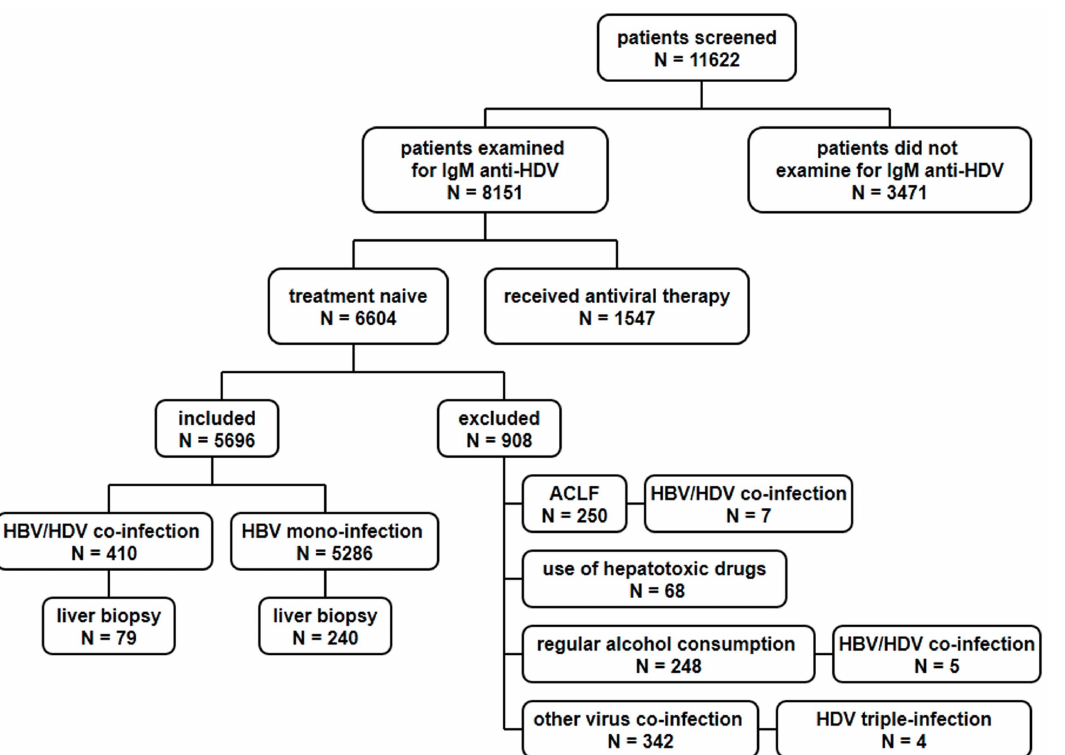
Fig. 1. Flow chart of study design. First, 11622 consecutive patients were screened from May 2005 to October 2011. Only 6604 treatment naive patients with chronic HBV infection were tested for IgM anti-HDVand the prevalence of HDV was investigated. Second, patients with ACLF, use of hepatotoxic drugs, regular alcohol consumption and other virus co-infection or triple-infection were excluded. The clinical characteristics of the remaining patients were then compared by HDV status. Finally, liver biopsies of 79 CHD patients were compared to those of 240 CHB patients.